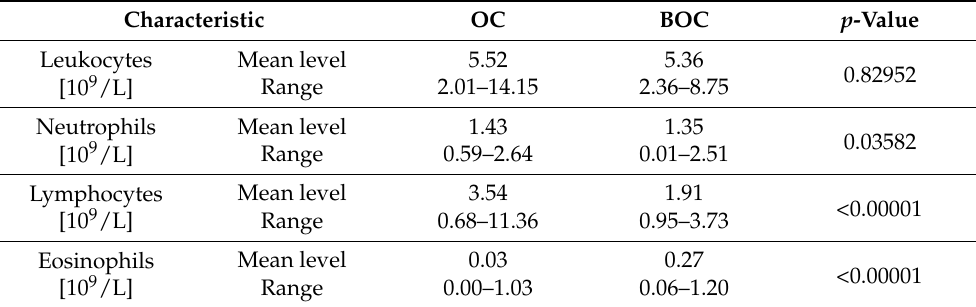
Table 4. Selected Blood Parameters in Ovarian Carcinoma and Benign Ovarian Cysts groups. Characteristic